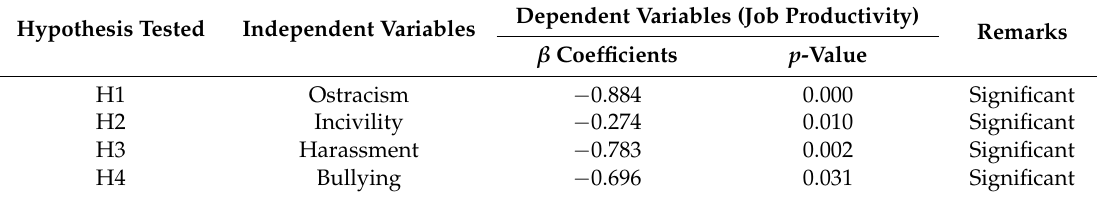
Table 5. Results of Direct Effects.